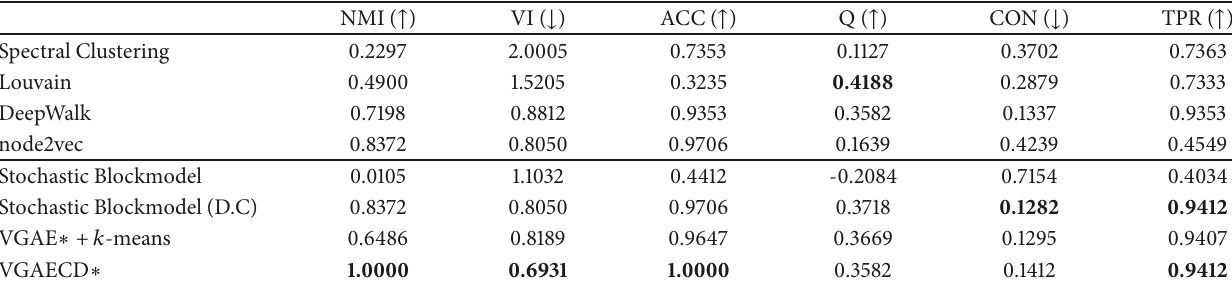
Table 2: Experimental results on Karate dataset.